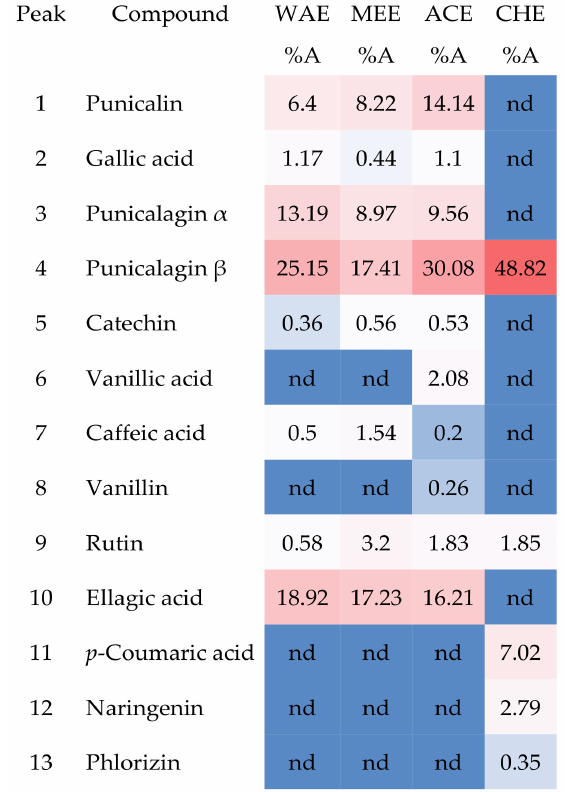
Figure 3. Chemical compounds of P. granatum bark extract in all solvents using HPLC-DAD, expressed as a relative percentage of the corresponding peaks areas (%A). Color indicates the relative quantity (red: high, white: medium; blue: low or not detected). nd: not detected; color is referred to the relative quantity of each phytochemical from low (blue), medium (white) to high (red).